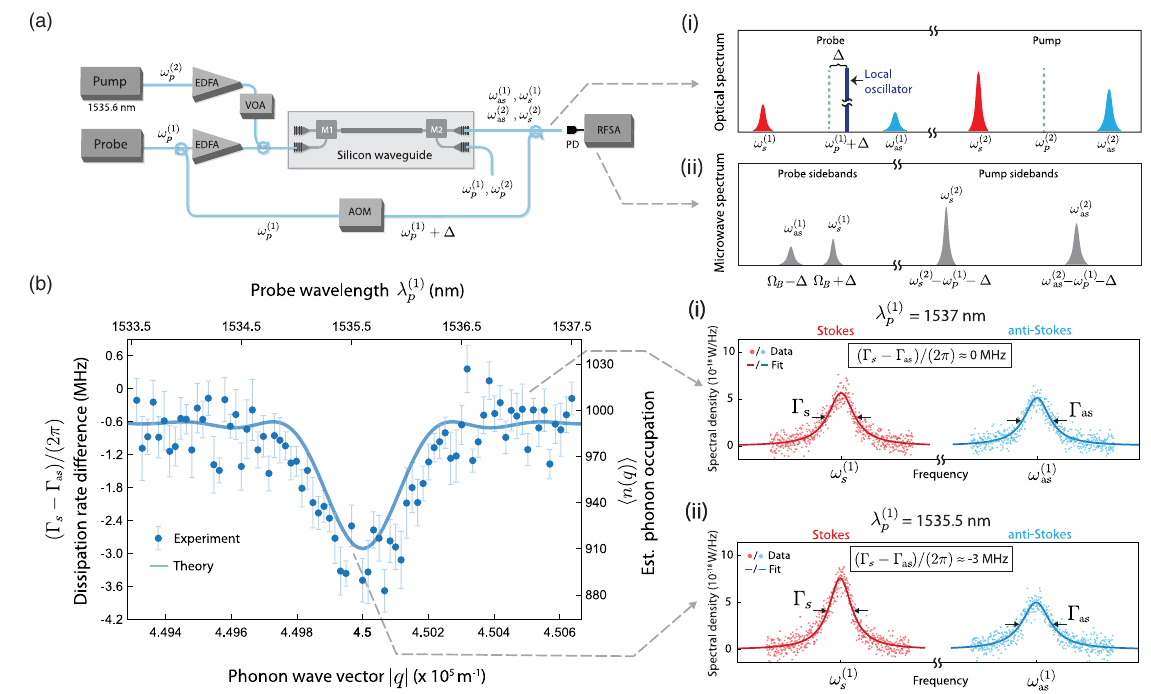
FIG. 3. Pump-probe spontaneous Brillouin scattering experimental setup and measurements. Panel (a) diagrams the experimental scheme used for the pump-probe experiments. These measurements involve two tunable cw lasers. The first, labeled the probe laser (indexed by superscript ð 1 Þ ), which has a fixed power of 8 mW, is used to probe the phonon dynamics. The second source, labeled the pump laser (indexed by superscript ð 2 Þ ), is used to modify the phonon dynamics. The optical local oscillator used for heterodyne detection is synthesized from the probe wave using an AOM. (ai) Optical spectrum incident on the fast photoreceiver and (aii) the resulting microwave spectrum. Since the optical LO (blueshifted 44 MHz by the AOM) is synthesized from the probe source, Δ and Ω − Δ , respectively) originate entirely from the the heterodyne Stokes and anti-Stokes signals centered at ( Ω B þ B spontaneously scattered probe light. Panel (b) shows the difference in Stokes and anti-Stokes phonon dissipation rates (spectral widths of the Stokes and anti-Stokes sidebands produced by the probe laser) as a function of probe wavelength, while the pump 2 Þ 1535 . 6 nm. Each data point represents the difference between Stokes and anti-Stokes dissipation wavelength remains fixed at λ ð p ¼ 2 Þ rates at a pump power ( P ð p ) of 30 mW obtained by fitting the measured spectral widths over a series of ten different pump powers. The average standard deviation is 0.375 MHz. The theoretical trend [see Eq. (3)] is superimposed. The phonon wave vector is calculated from the effective phase and group indices of the two optical spatial modes supported by the silicon waveguide (see Appendices C and F), and the anti-Stokes phonon occupation is estimated by a comparison with the spatiotemporal theory. This comparison is verified by additional high-resolution pump-probe experiments (see Appendix D). (bi) Example spectra (of the probe sidebands) when the probe wave is not phase matched to the same group of phonons as the pump wave. In this case, the dissipation rates for the Stokes and anti- Stokes phonons remain constant as the pump power increases. (bii) Example spectra (of the probe sidebands) when the probe wave is phase matched to the same group of phonons as the pump wave. Here, increasing the pump power enhances the dissipation rate asymmetry (see also Appendix D). These data reveal that the pump wave reduces the phonon occupation over a narrow band of phonon wave vectors, with a bandwidth given by Δ q ¼ 2 . 78 =L (see Appendix